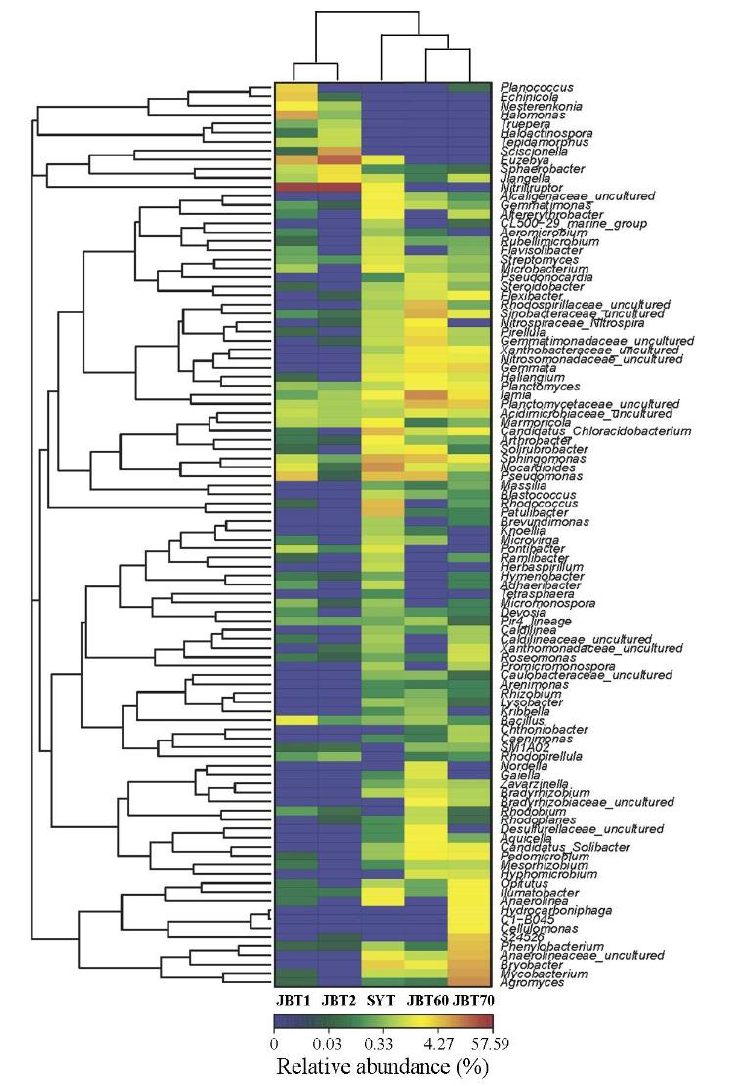
Figure 4. Hierarchically clustered heatmap of bacterial distribution of different communities from the five samples at the genus level. Row represents the relative percentage of each bacterial genus, and column stands for different samples. The relative abundance for each bacterial genus were depicted by color intensity with the legend indicated at the under of the figure. The abbreviation of samples is shown in Table